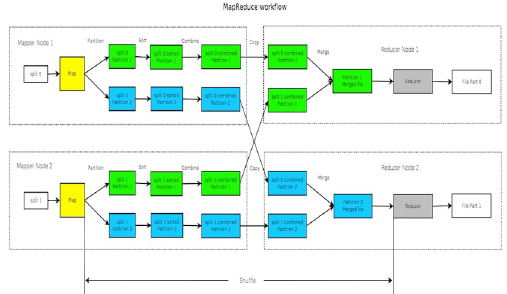
Figure 2. MapReduce